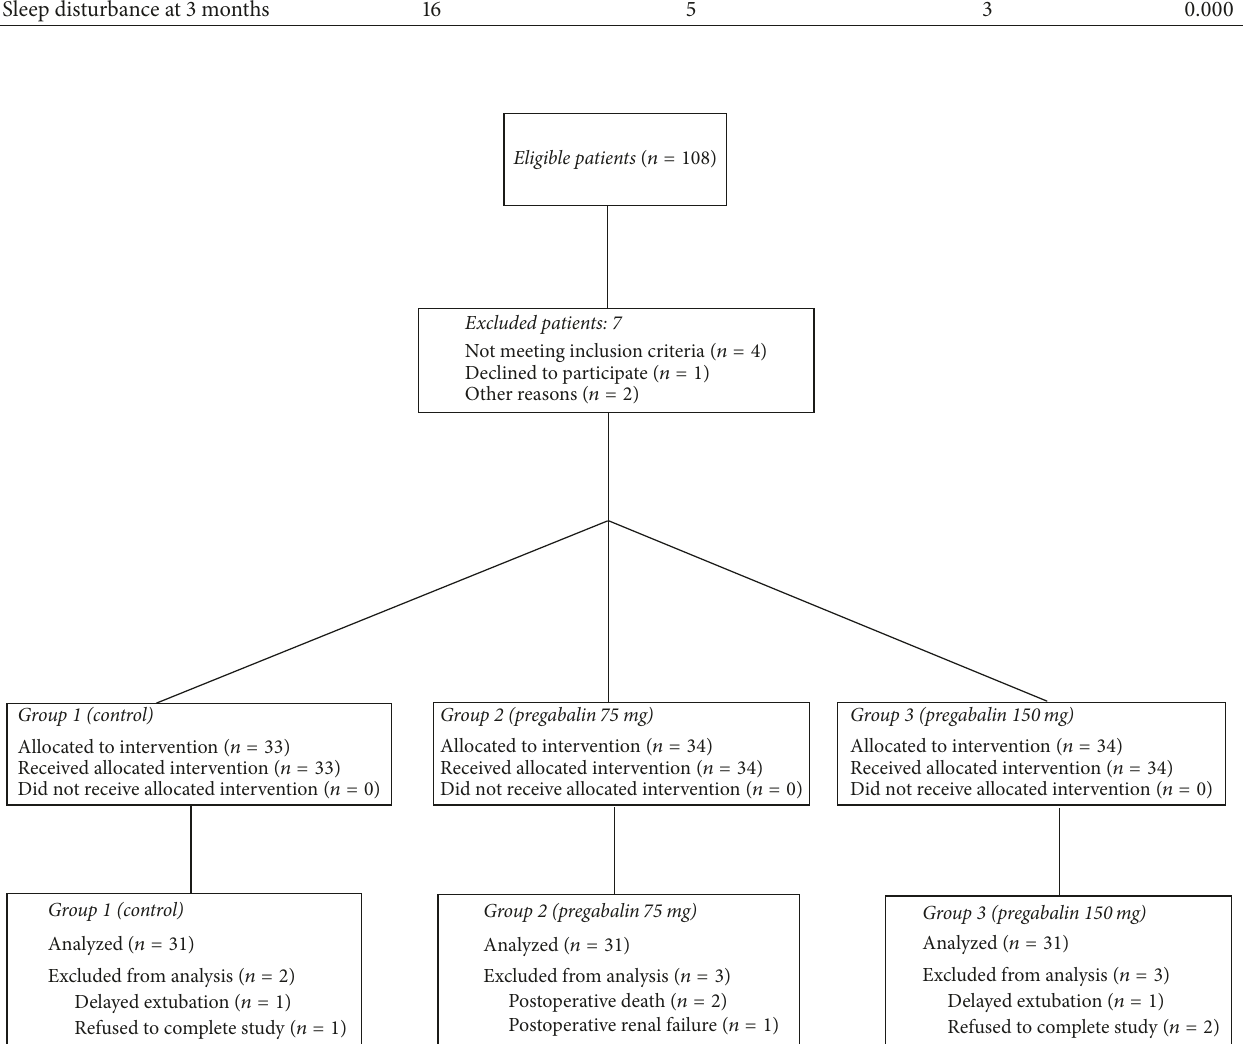
Figure 1: CONSORT diagram showing the progression of patients from eligibility to enrollment to completion of the